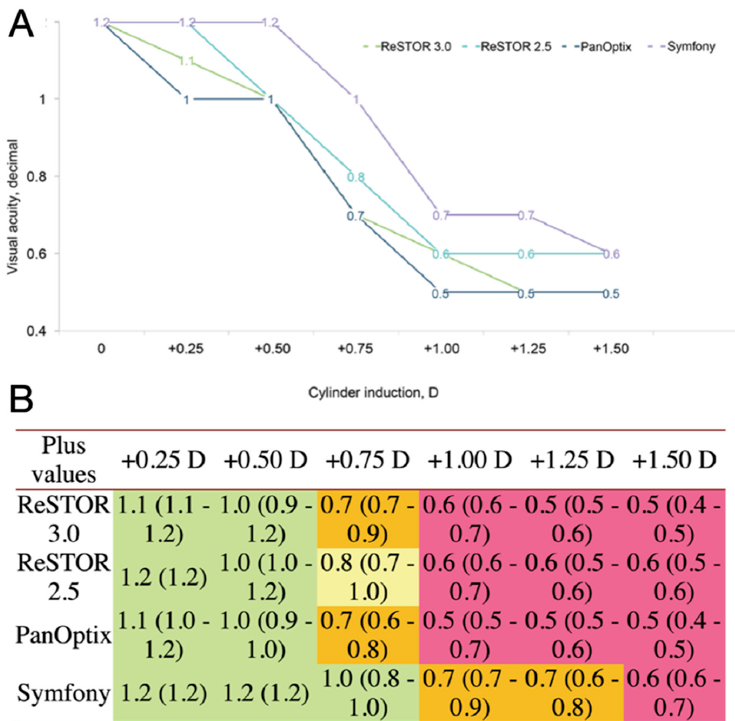
Figure 4. Mean visual acuity with four multifocal IOLs after the induction of different values of positive cylinder. Mean visual acuity ( A ) and patient satisfaction scores ( B ) with four multifocal IOLs after the induction of di ff erent values of positive cylinder (green 1 ⁄ 4 very satis fi ed; yellow 1 ⁄ 4 moderately satis fi ed; orange 1 ⁄ 4 not satis fi ed; red 1 ⁄ 4 not at all satis fi ed). Values are reported as median, with range in brackets [11].